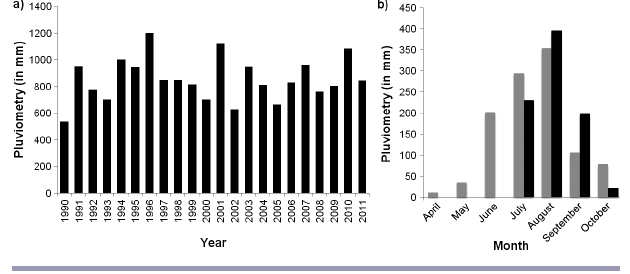
Fig. 2 . Precipitation in Dukula, the main village of the district. a) Precipitation between 1990-2011. For this period, the mean annual precipitation was 854.75 mm (standard deviation 163 mm). b) Precipitation during the rainy seasons in 2010 (in grey) and 2011 (in black). Source: SODECOTON, Maroua, North Cameroon ( unpublished data